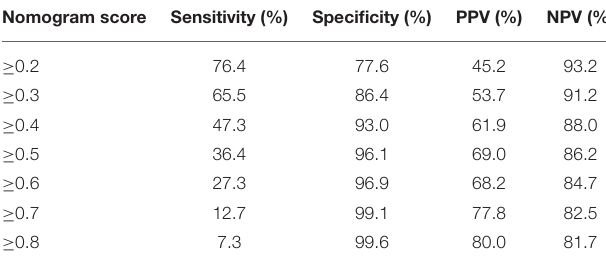
TABLE 4 | Values of sensitivity, specificity, and predictive values of the nomogram scores at different cutoff